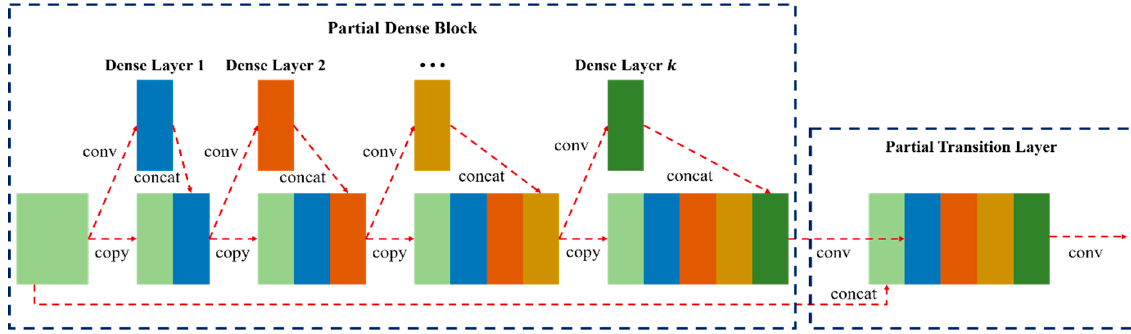
Figure 6. CSPNet structure.